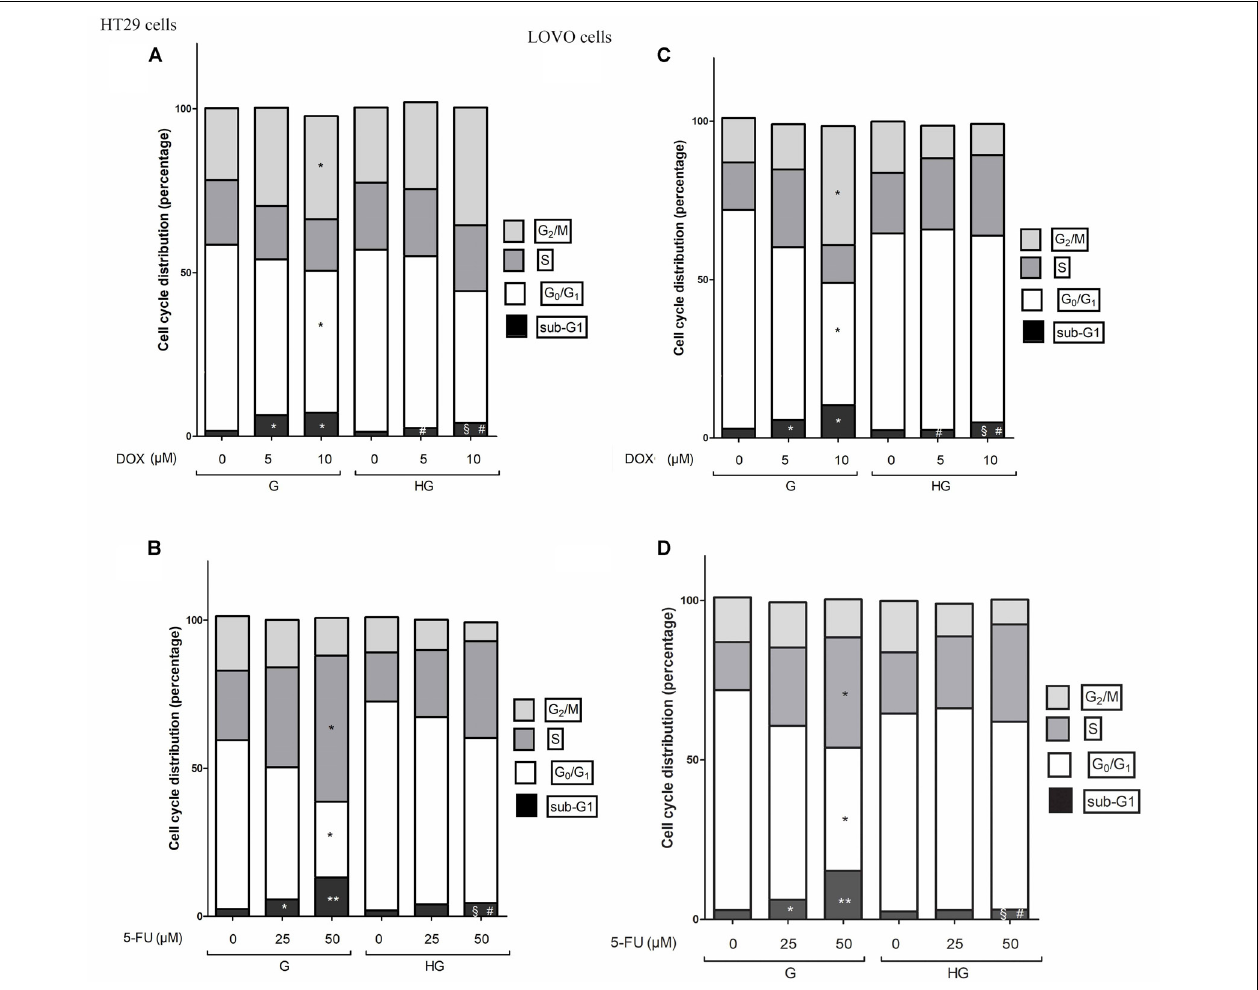
FIGURE 12 | Effect of normal glucose (G) and high glucose (HG) on cell cycle in HT29 and LOVO cells in absence or presence of DOX (A,C) or 5-FU (B,D) . Cells were cultured for ≥ 7 days in the presence of G and HG, incubated for 24 h before analysis with 5 and 10 µ M DOX (A,C) or for 72 h with 25 and 50 µ M 5-FU (B,D) and then cells were analyzed for DNA content by FACS analysis. Panels represent the distribution of cells in different phases of cell cycle. Measurements ( n = 3) were performed and data are presented as means ± SEM. (A,C) ∗ p < 0.01 5 and 10 µ M DOX in HT29 cells cultured in G vs. 0 µ M DOX in HT29 cells cultured in G; § p < 0.01 10 µ M DOX in HT29 cells cultured in HG vs. 0 µ M DOX in HT29 cells cultured in HG; # p < 0.01 5 and 10 µ M DOX in HT29 cells cultured in HG vs. 5 and 10 µ M DOX in HT29 cells cultured in G. (B,D) ∗ p < 0.01 and ∗∗ p < 0.001 25 and 50 µ M 5-FU in HT29 cells cultured in G vs. 0 µ M 5-FU in HT29 cells cultured in